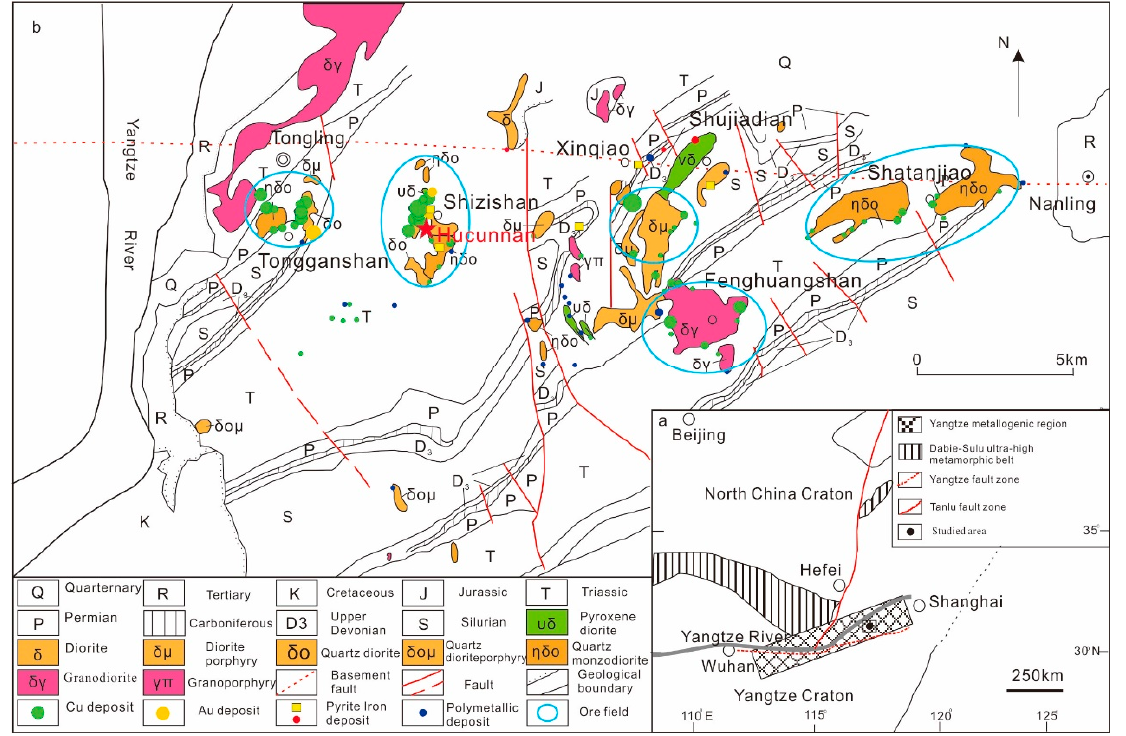
Figure 1. Geological sketch maps of ( a ) Lower Yangtze River Metallogenic Belt and ( b ) Tongling ore cluster, East China [26].